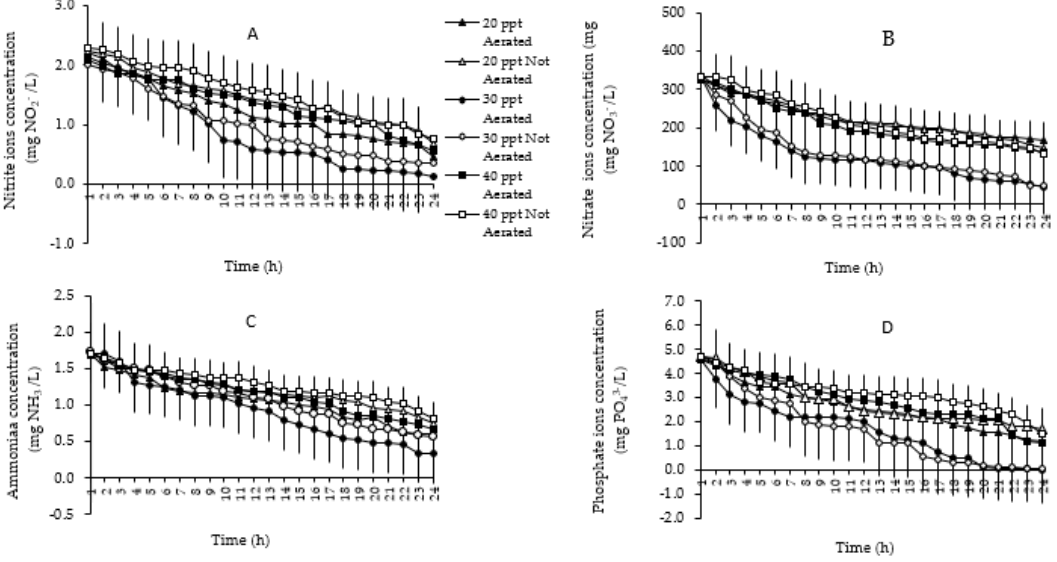
Figure 3. Changes over time in concentrations of nitrite (NO 2 − ) ( A ), nitrate (NO 3 − ) ( B ), ammonia (NH 3 ) ( C ), and phosphate (PO 43 − ) ( D ) at three salinity levels with and without aeration at 30 g / L Caulerpa lentillifera density. The error bars indicate standard deviations. n = 3.